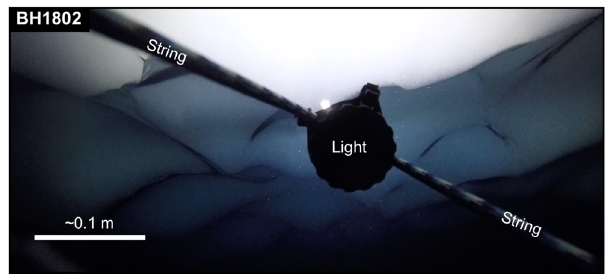
Fig. 2 Ice-surface geometry. Lower surface of ice at BH1802 as observed by an upward-looking camera (see also Supplementary